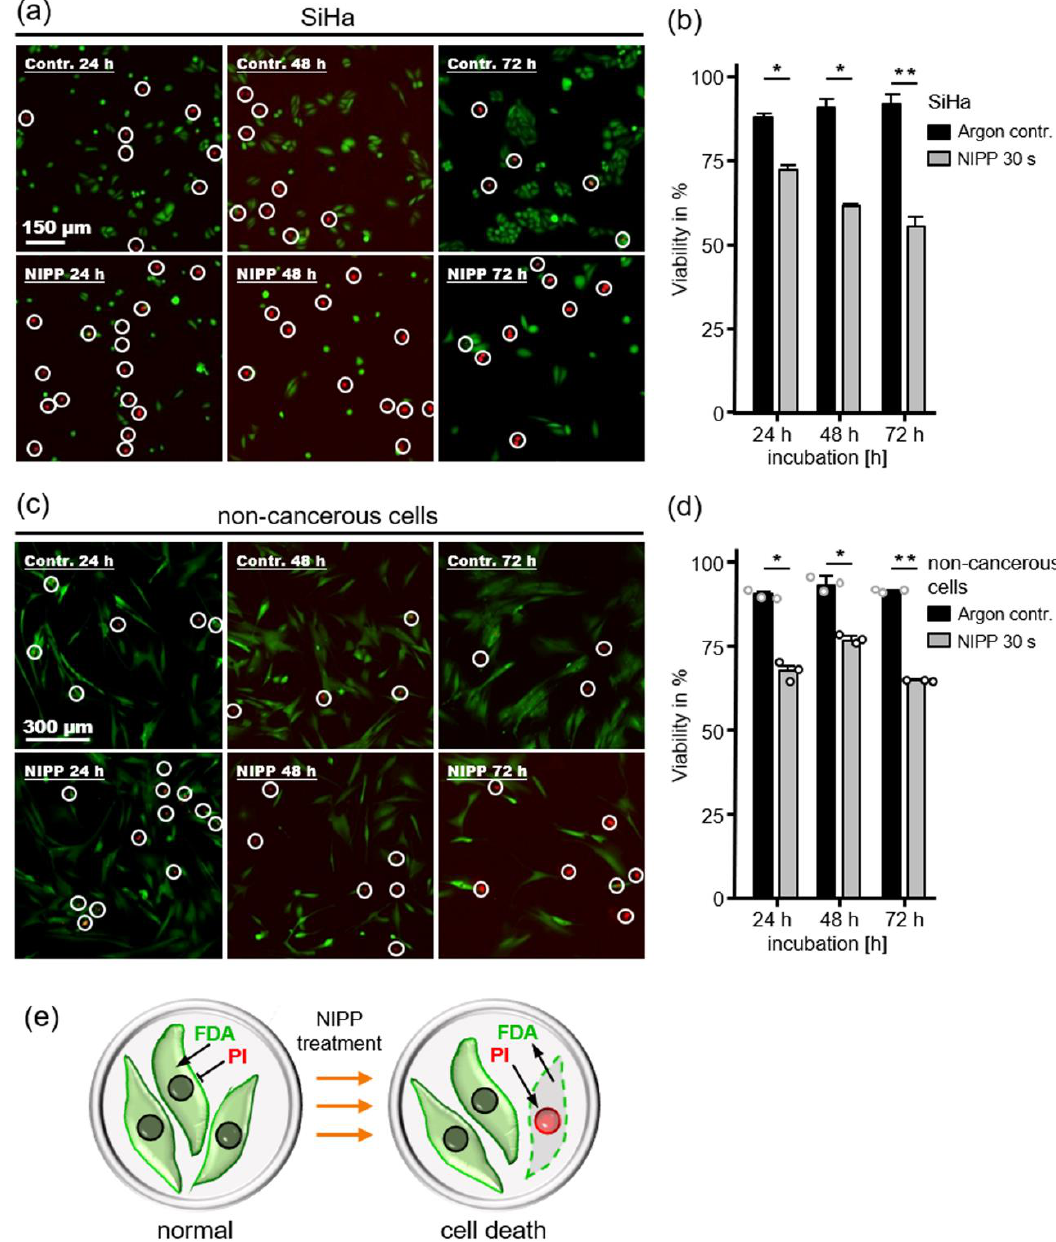
Figure 2. NIPP effects on cellular viability and membrane integrity of CC cells and primary non-cancerous cells from healthy cervical tissue. Cells were NIPP- or argon gas-treated for 30 s and analyzed after 24, 72 and 120 h. ( a , c ) Representative fluorescence microscopy after staining of native cells with PI and FDA. White circles indicate the presence of red stained cell nuclei. ( b , d ) Relative live/dead ratio by automatic counting of red and green fluorescent nuclei, using the image analysis software ImageJ compared to argon gas-treated controls. ( e ) Schematic functionality of FDA and PI staining in viable and dead cells. The results are expressed as the mean ± SD of three independent experiments. For non-cancerous cells, each independent experiment was performed with cells from a different donor. * p < 0.05, ** p < 0.01, as determined by Student’s t -Test.